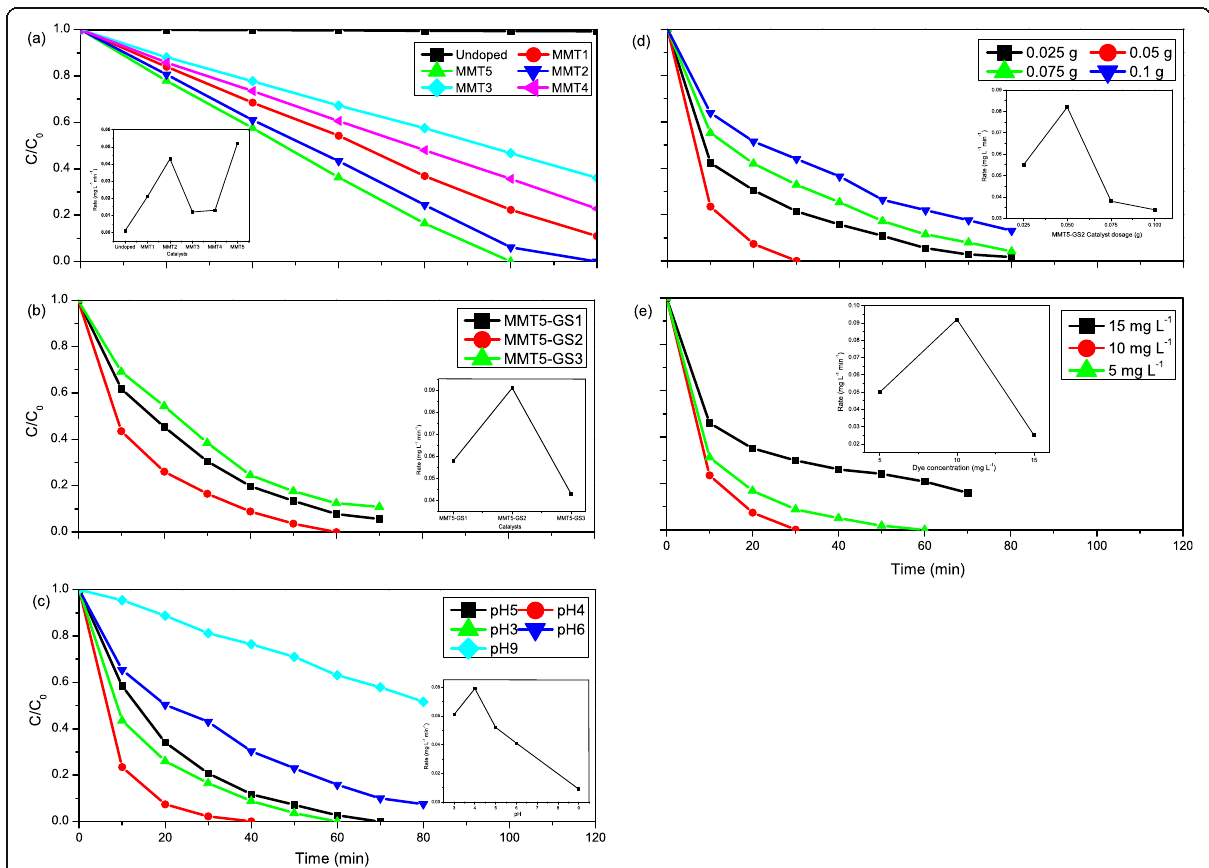
Fig. 9 a Effect of dopant concentration of bimetal doped TiO 2 on photocatalytic degradation of MR dye. Here, catalyst dosage 0.05 g, solution pH 4 and [MR] = 10 mg L − 1 . b Effect of GS concentration on the photocatalytic activity of MMT5 on the degradation of MR. Here catalyst dosage is 0.05 g, solution pH 4 and [MR] = 10 mg L − 1 . c Effect of pH on the rate of degradation of MR dye by MMT5-GS2. Here, catalyst dosage 0.1 g and [MR] = 10 mg L − 1 . d Effect of catalyst dosage on the degradation of MR by MMT5-GS2. Here, solution pH 4 and [MR] =10 mg L − 1 . e Effect of the initial dye concentration on the rate of degradation of MR dye by MMT5-GS2. Here, solution pH 4 and catalyst dosage 0.05